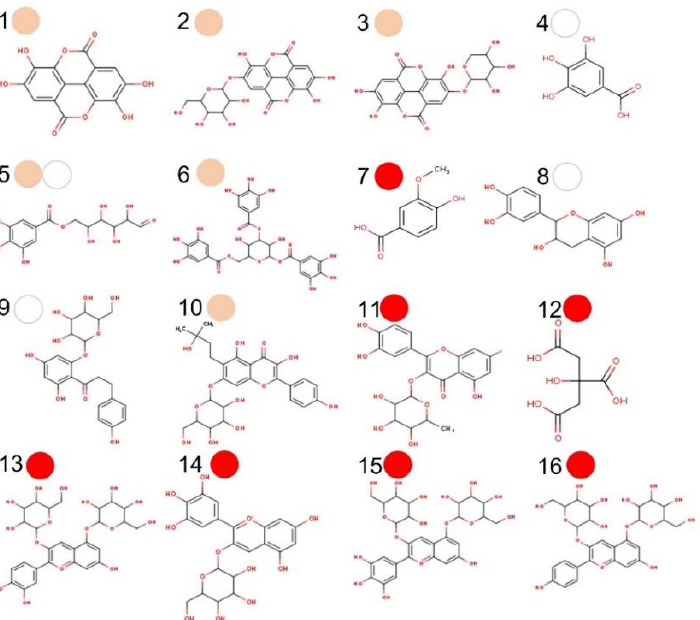
Figure 2. Major phytochemicals in pomegranate (PMG) fruits (aryls) of different color. Ellagic acid ( 1 ), ellagic acid glucoside ( 2 ), ellagic acid-4-O-xylopiranoside ( 3 ), gallic acid ( 4 ), galloyl-6-O-glucoside ( 5 ), 1,3,6-tri-O-galloyl-D-glucose ( 6 ), vanilic acid ( 7 ), D-(+)-catechin ( 8 ), phlorizin ( 9 ), phellatin ( 10 ), quercitrin ( 11 ), citric acid ( 12 ), cyanidin-3,5-O-glucoside ( 13 ), delphinidin-3-O-glucoside ( 14 ), delphinidin-3,5-O-diglucoside ( 15 ), and pelargonidin-3,5-O-diglucoside ( 16 ). The major PMG source is depicted as a correspondingly colored circle (red, pink, white).